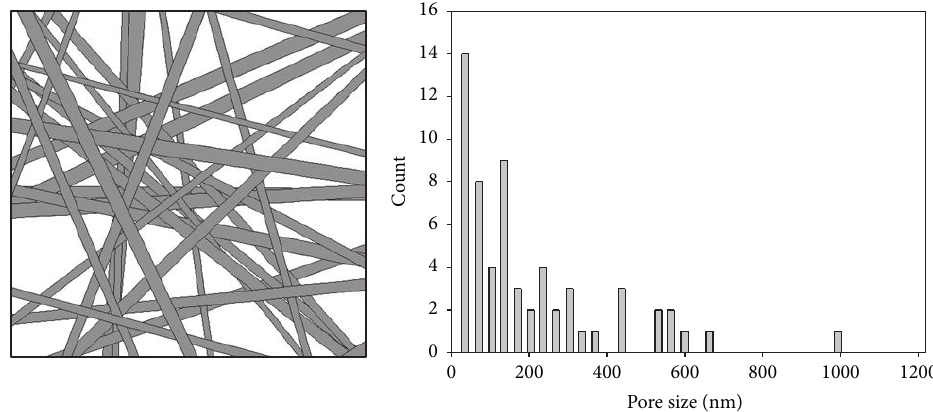
Figure 4: The simulated N6-35 nanofibrous structures and its pore size distribution to be compared with Figure 1.